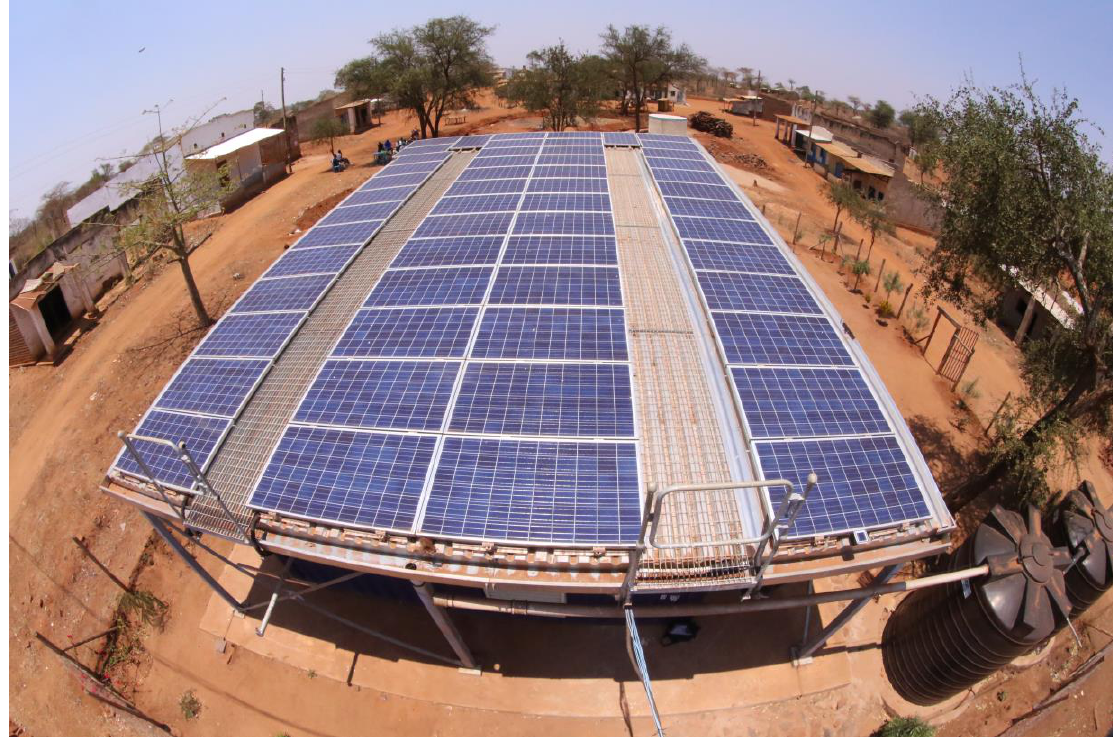
Figure 2. PV system in Kitonyoni trading centre where the modules were installed on a canopy that provides shading for the community as well as harvesting rainwater (2 × 10,000 l storage tanks, front right of image).